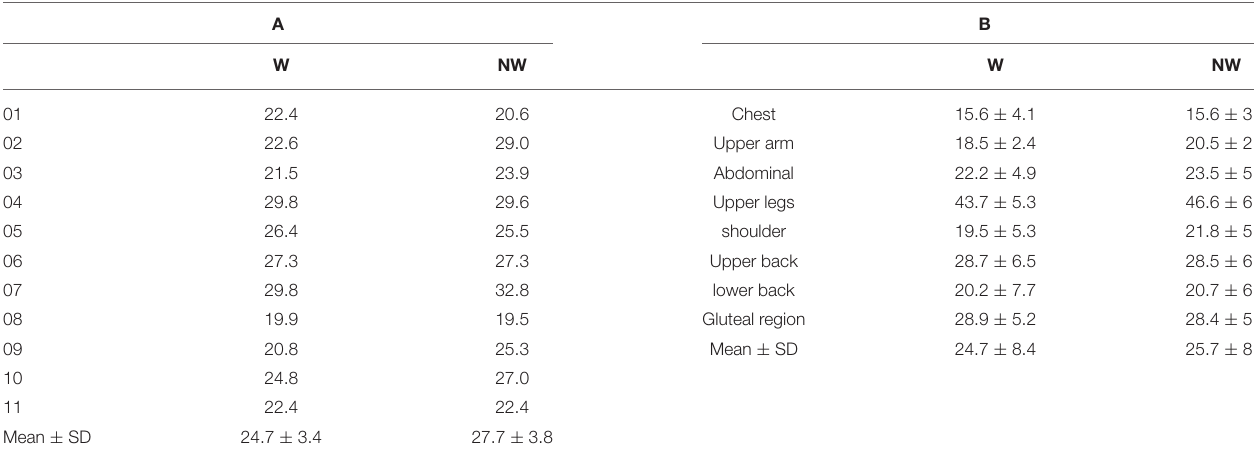
TABLE 2 | Whole-body electrical muscle stimulation (WB-EMS) intensity.